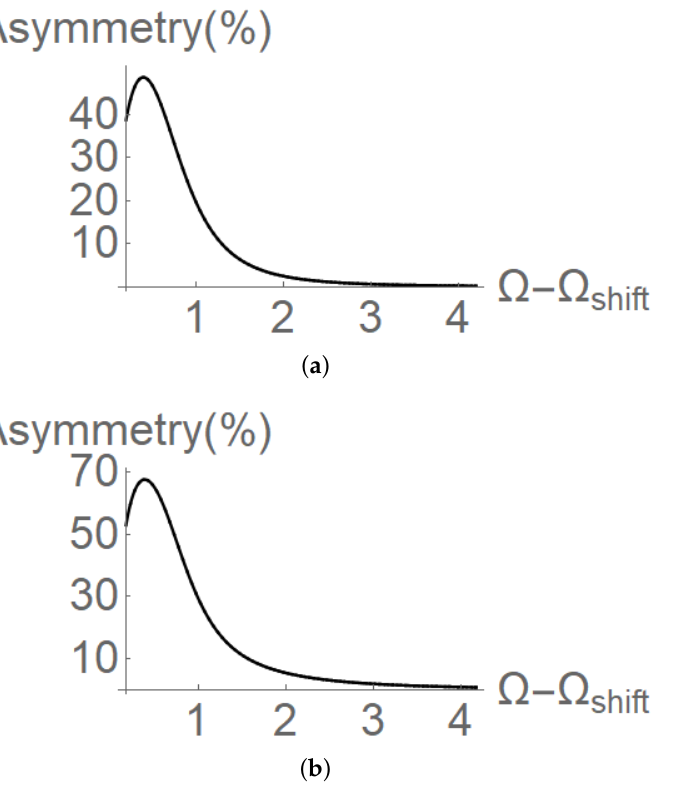
( Ω − Ω shift ) − T ( − Ω + Ω shift ) 100) as function of the normal- T ( Ω − Ω shift ) = 0.25 and ( b ) L = λ λ